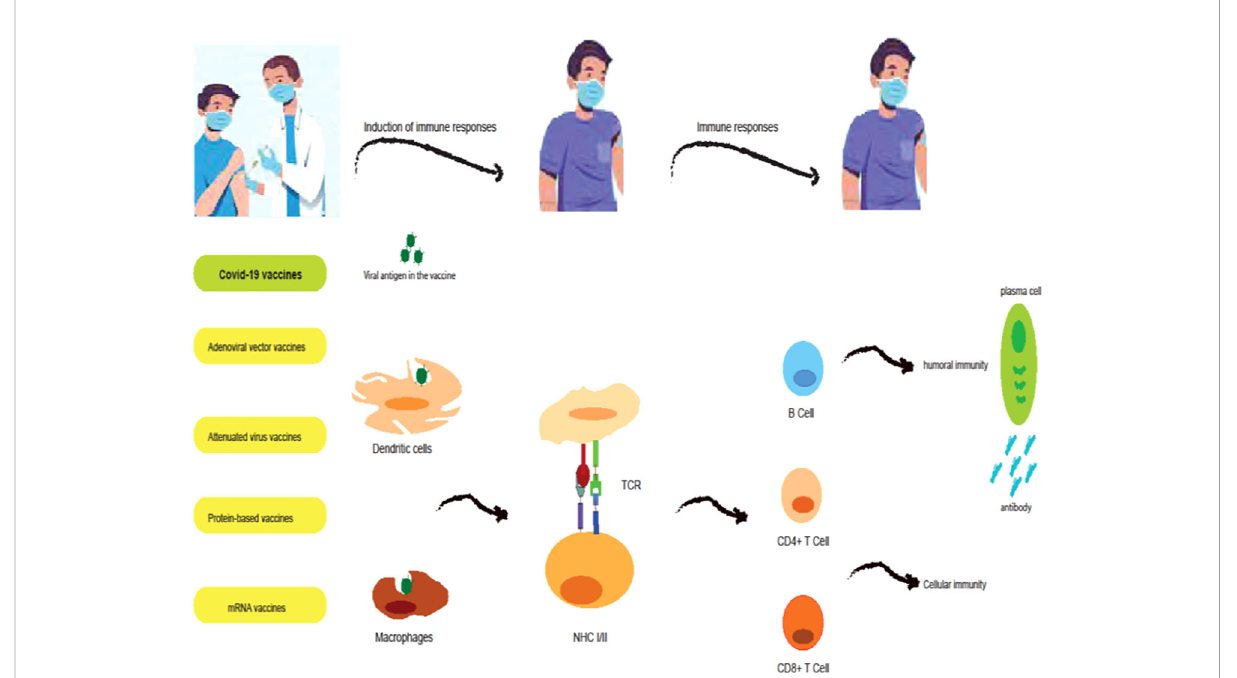
FIGURE 1 Induction of immune responses by COVID-19 vaccines. mRNA vaccines (BNT162b2 and mRNA-1273 vaccines) are a modi fi ed version of the spike protein which is translated by ribosomes, secreted by the bystander cell, and in turn taken up and processed by antigen-presenting cells (APCs; dendritic cells (DCs)). Adenoviral vector vaccines (ChAdOx1, Ad26.COV2.S, and Sputnik V vaccines) contain cDNA encoding a full-length spike protein. cDNA is transported to the nucleus where it is transcribed to mRNA and subsequently translated into spike protein in the cytoplasm. This spike protein is then taken up and processed by APCs. Protein-based vaccines (NVX-CoV2373 vaccines) consist of the spike protein and an adjuvant which is directly processed by APCs. Attenuated virus vaccines (CoronaVac and BBIBP-CorV vaccines) contain whole inactivated virus particles and adjuvants which APCs directly process. In the lymph nodes, APCs will present processed peptides and thus activate T cell responses and B cell responses, and antibody